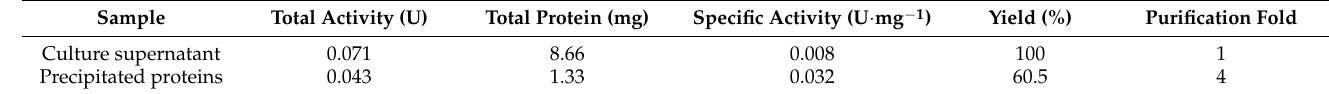
Table 3. Summary of extracellular cellulase